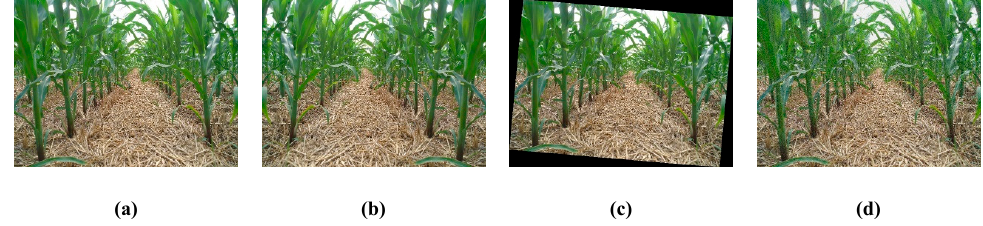
Figure 4. data enhancement method. ( a ) original image; ( b ) mirrored image; ( c ) affine transformed image; ( d ) noisy image.